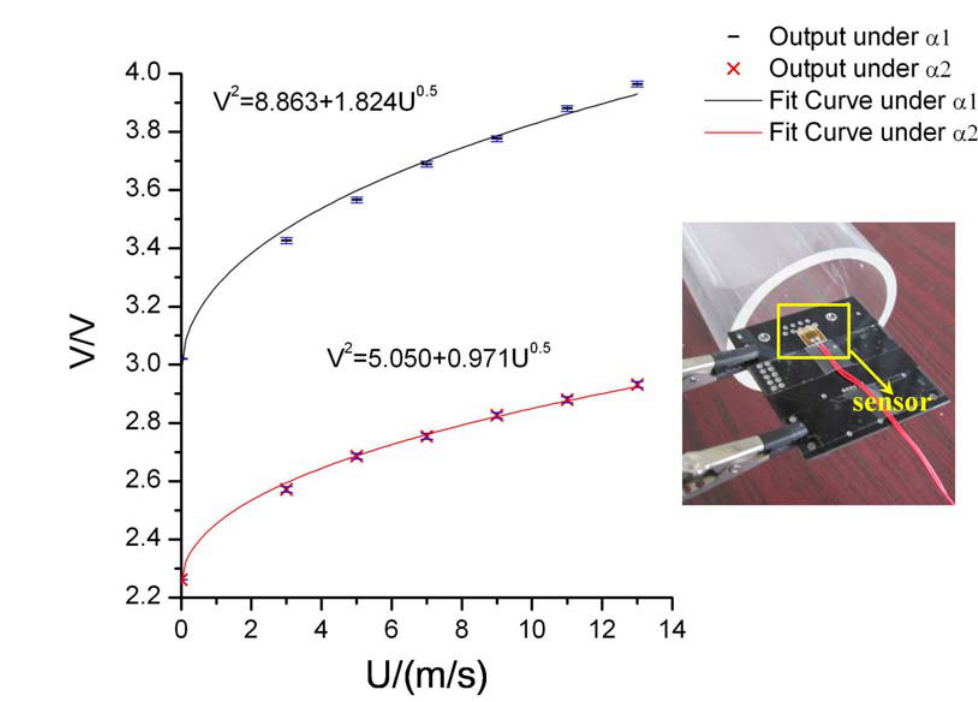
Figure 5. Measurement results of the sensor with error bars under constant temperature mode. Bridge ratio of the CT circuit is 20, and overheats ratio α 1 and α 2 are set as 0.03 and 0.02